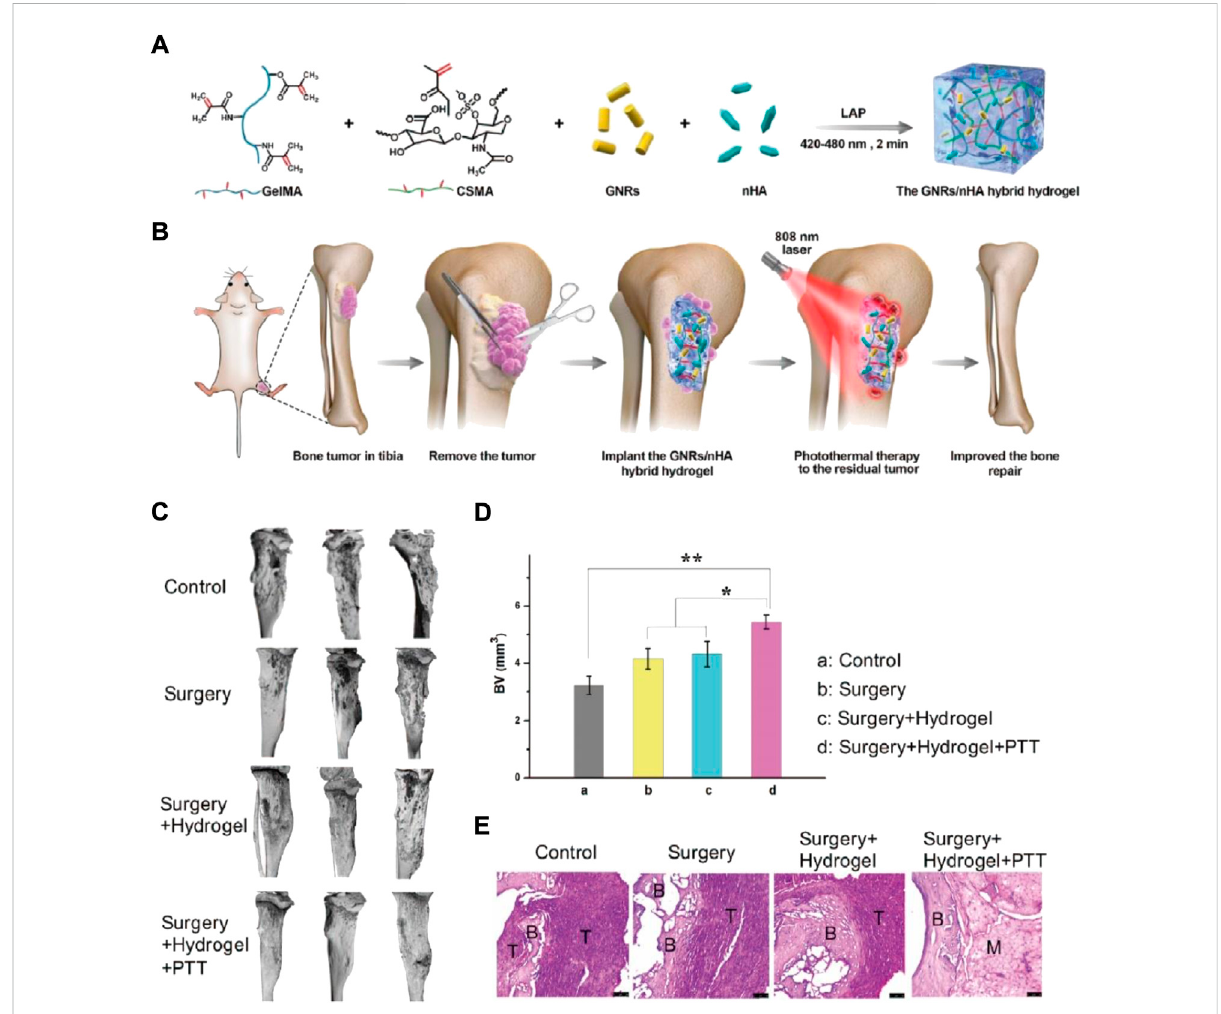
FIGURE 4 (A) The diagrammatic GNRs/nHA hybrid hydrogel preparation. (B) The hybrid GNRs/nHA hydrogel application for photothermal treatment and regeneration of bone tumor. (C) The micro-CT reconstruction in each group of mice after treatment for 2 weeks; (D) The bone volume